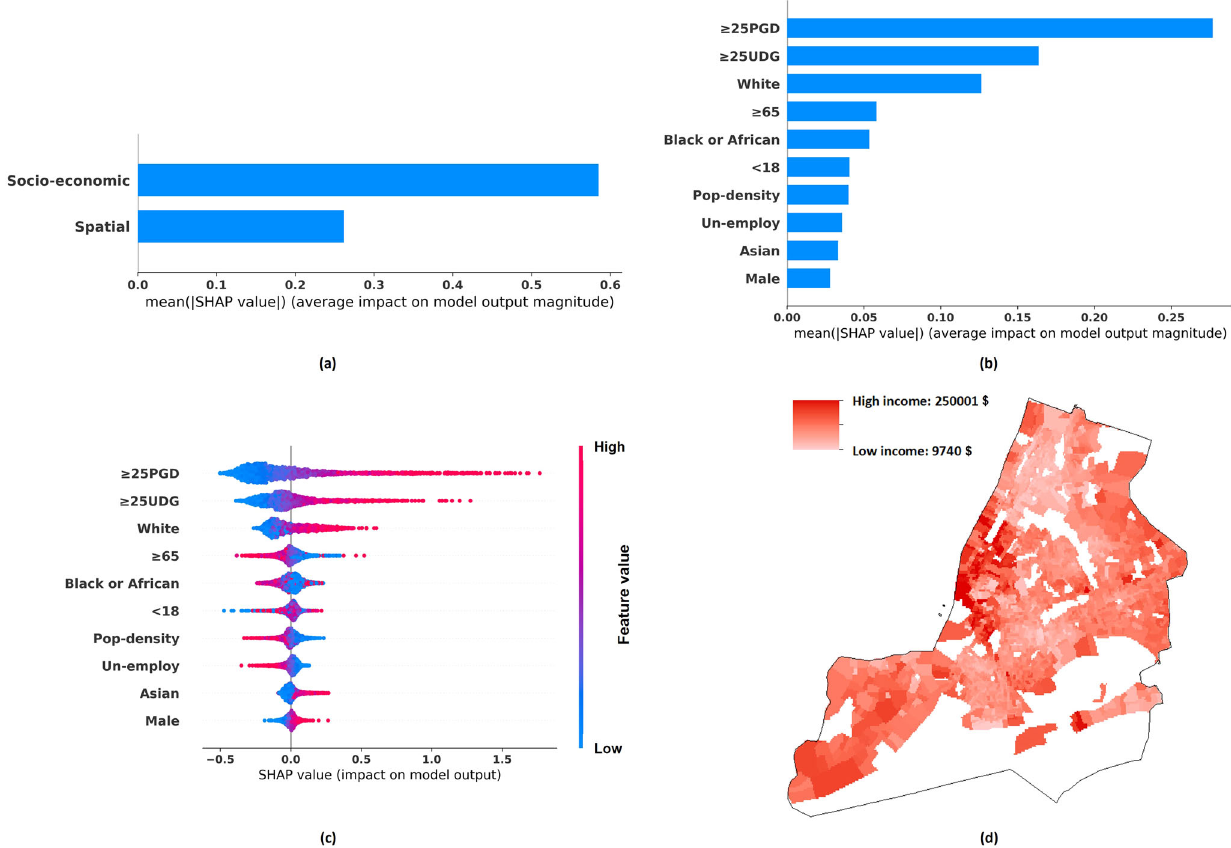
Fig. 3 Tract-level median household income distribution and SHAP analysis results. a The mean absolute SHAP value indicating the total contribution of spatial or socio-economic features to Tract-level median household income estimation. b The mean absolute SHAP value indicating the contribution of individual socio-economic features to Tract-level median household income estimation. c The SHAP value indicating the contribution of individual socio- economic features to Tract-level median household income estimation, with each dot corresponding to a value of a particular Tract/district. d Tract-level median household income